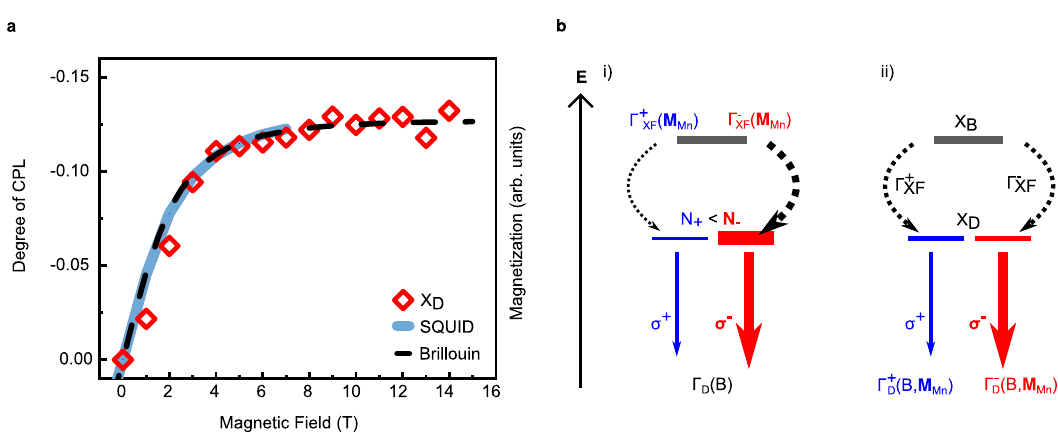
Fig. 4 Relation between magnetization and CPL polarization in Mn:PEPI and proposed interaction mechanism. a Superposition of PL polarization and magnetization curve of Mn:PEPI at 4 K and Brillouin function for a non-interacting J = 5/2 spin system. b Schematic of proposed interaction between excitons and manganese spins in an external magnetic fi eld. X B and X D denote bright and dark exciton, respectively. Γ XF is the exciton formation rate, N the occupancy of the state, σ the polarization of emission, Γ D is the dark exciton emission rate depending on the magnetic fi eld strength B and the manganese magnetization M Mn . Superscript and subscript + / − denote the corresponding spin state. (i) A magnetization-dependent exciton formation rate favors the occupation of a speci fi c spin state. (ii) Dark exciton spin states are occupied equally, but the manganese induces a spin-dependent recombination pathway leading to different radiative